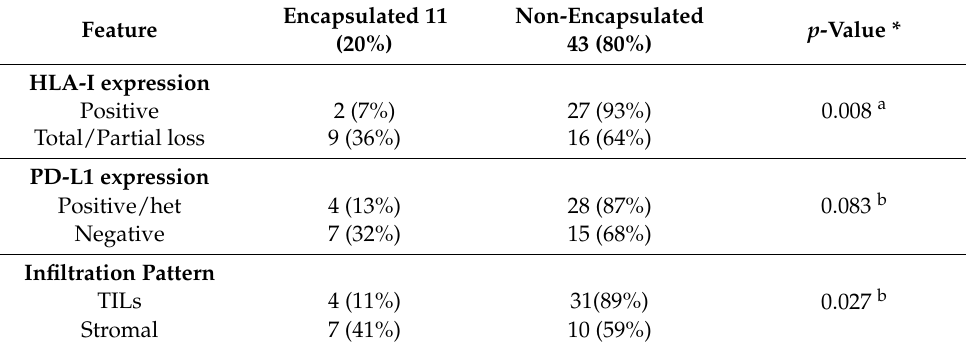
Table 5. Association of tumor encapsulation with HLA-I, PD-L1 expression and T-cell infiltra- tion